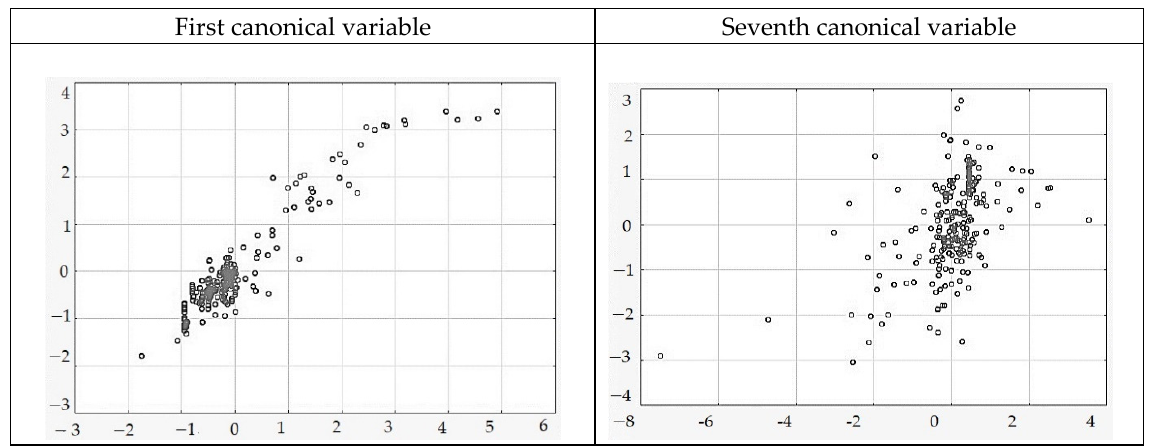
Figure 2. Scatter plot of the first and last statistically significant canonical variable.